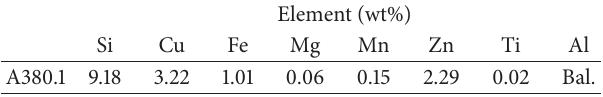
Table 1: Chemical composition of the as-received 380 alloy